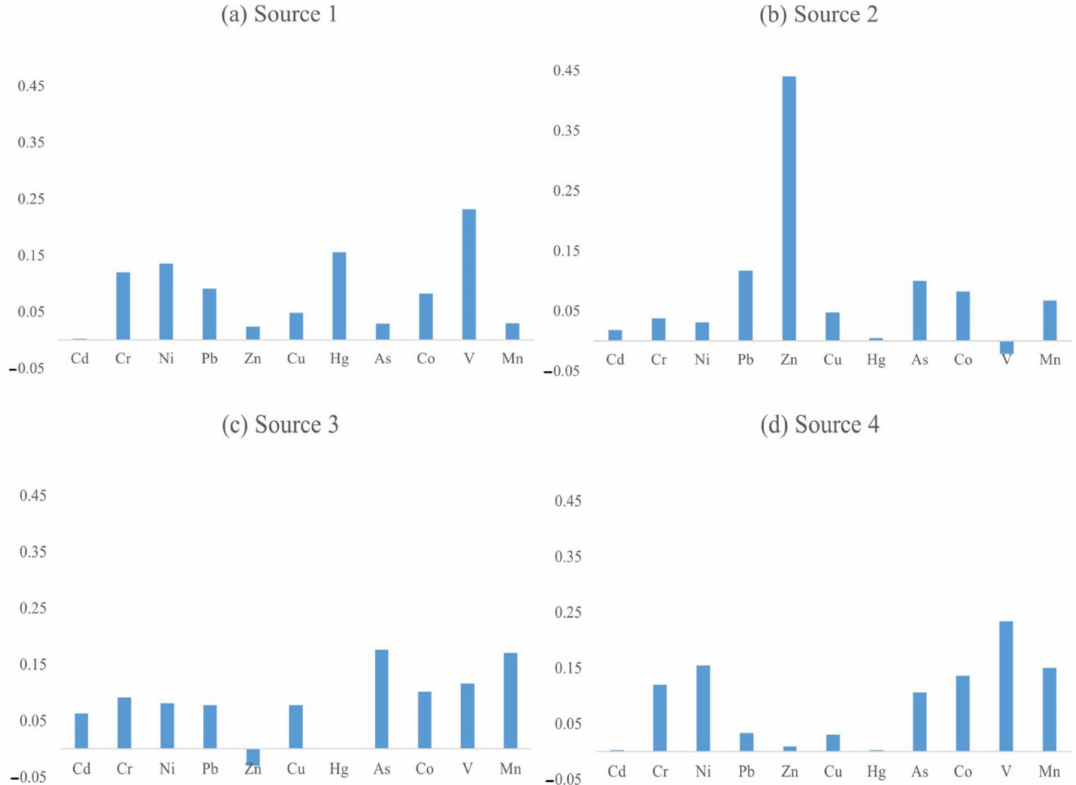
Figure 7. Source apportionment diagrams of the soil heavy metals based on the Unmix